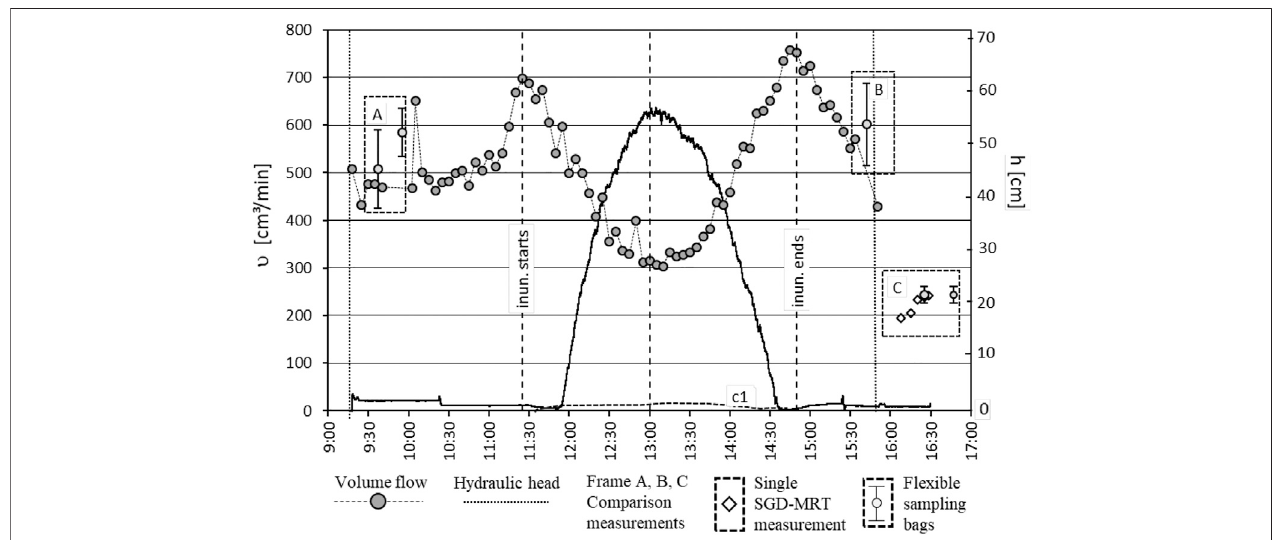
FIGURE 8 | Time series data at Sahl#1 of fl uid discharge rates (cm³/min) and hydraulic head (cm) measured by the SGD-MRT and the salinity inside the benthic chamber (c1, 2.3 mS/cm) recorded by a CDT diver. The data frames A and B compare discharge rates measured by the SGD-MRT and the fl exible sampling bags. Frame C compares discharge rates located aside from the main location. Conventional Lee-type seepage meter measurements are indicated by a grey circle with an error bar. The period of the inundation of the discharge site is indicated by inun.starts and inun.ends.